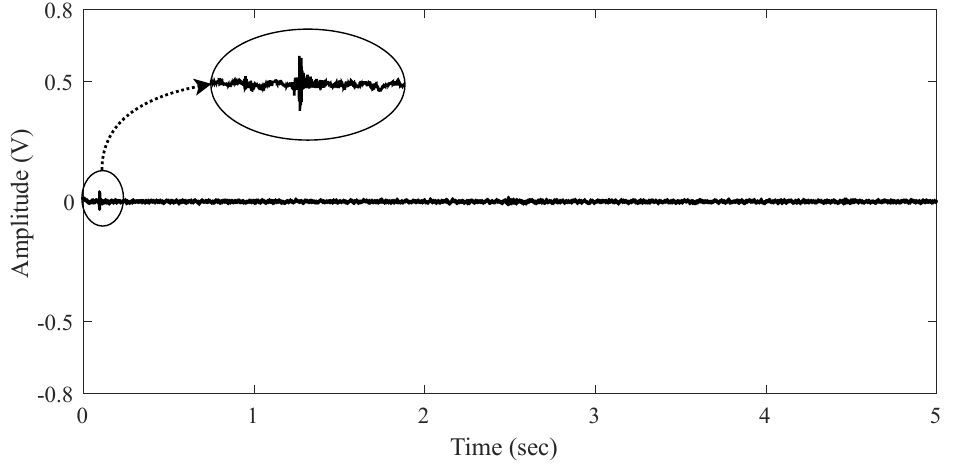
Figure 6. Signal behavior in the hall scenario without audio source.